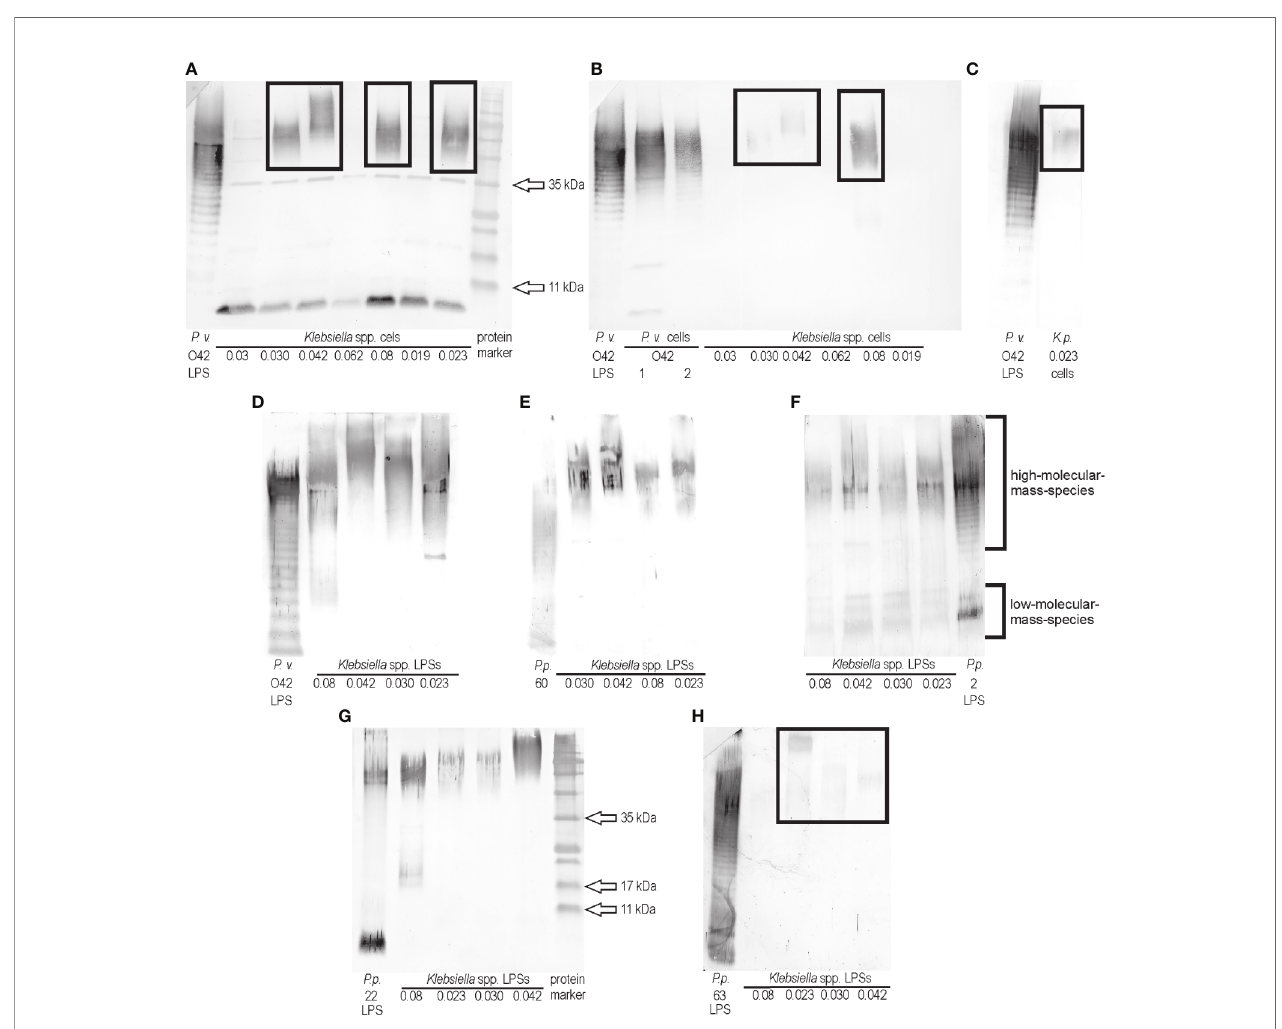
FIGURE 1 | Western blotting reactions of (A) P. vulgaris O42 antiserum with Klebsiella spp. cells, (B) , (C) P. vulgaris O42 antiserum with Klebsiella spp. cells treated with proteinase K, (D) P. vulgaris O42 antiserum, (E) P. penneri 60 antiserum, (F) P. penneri 2 antiserum, (G) P. penneri 22 antiserum, and (H) P. penneri 63 antiserum with Klebsiella spp. LPSs. Proteus spp. LPSs homologous to the tested sera were used as the controls of the reactions speci fi